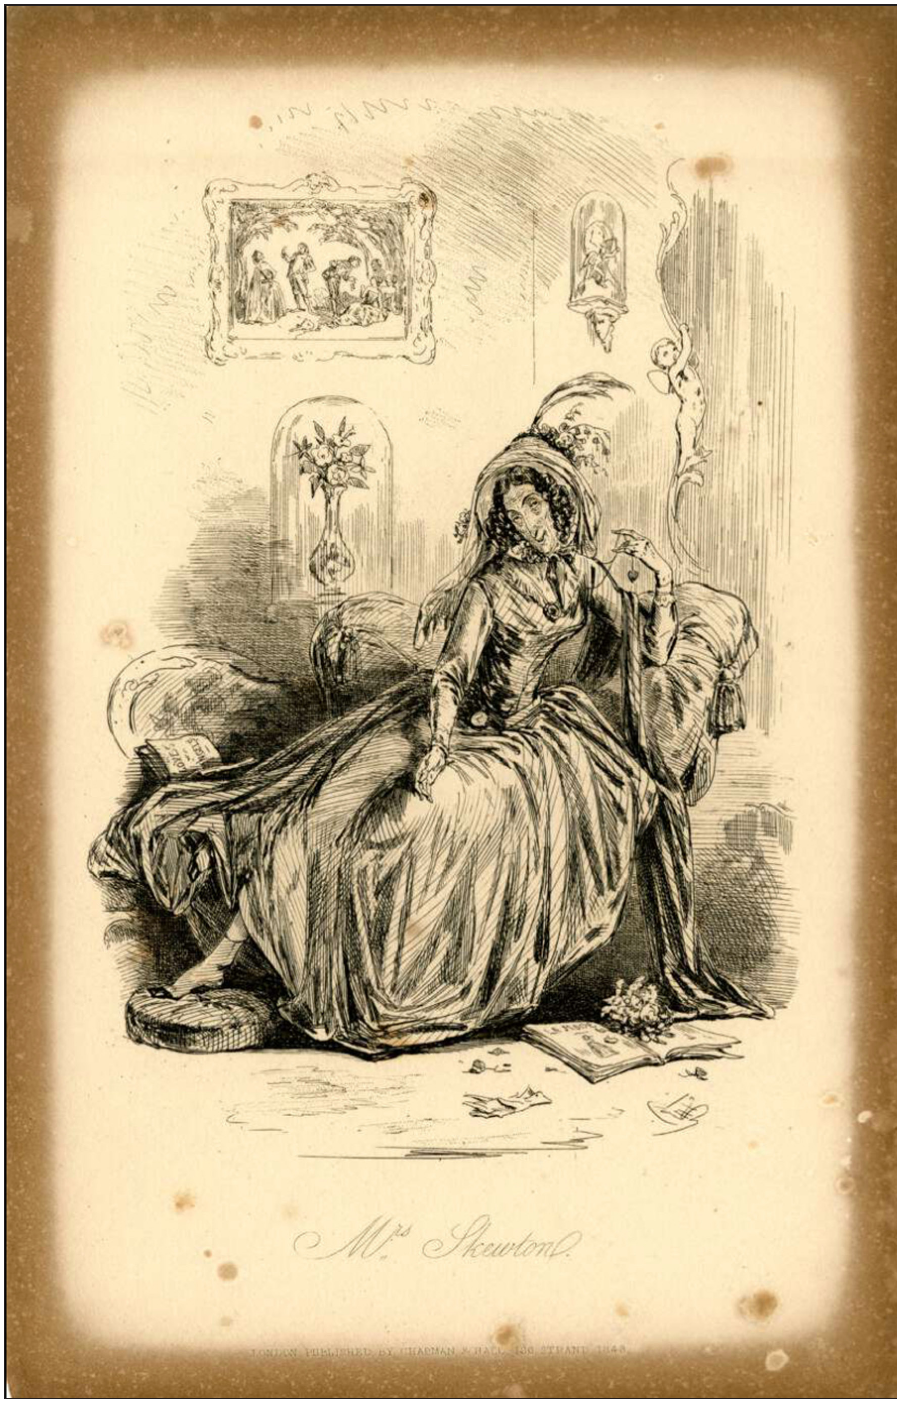
Fig. 1: Hablot Knight Brown (‘Phiz’), Mrs Skewton , illustration to Charles Dickens, Dombey and Son (London: Chapman & Hall, 1848), etching, 22.6 × 14.3 cm, British Museum, London. © The Trustees of the British